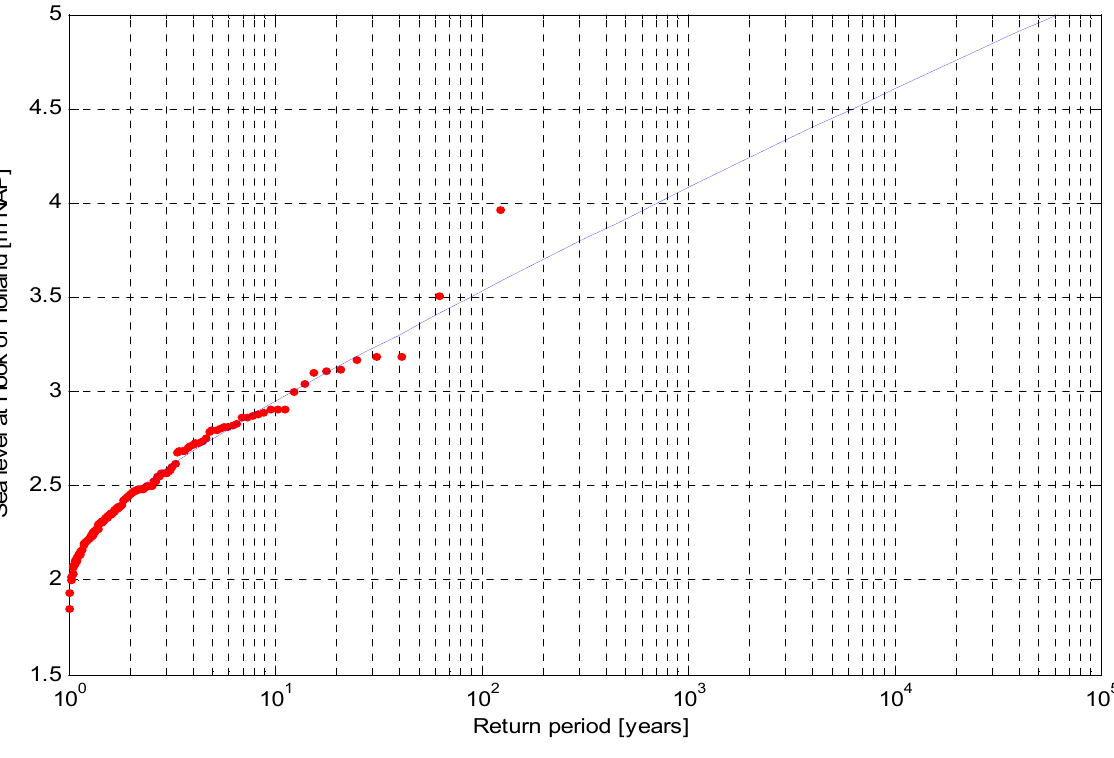
Figure 10 indicates the return period of sea levels based on the Equation (11) at Hook of Holland. Figure 10. Return period of the sea levels at Hook of